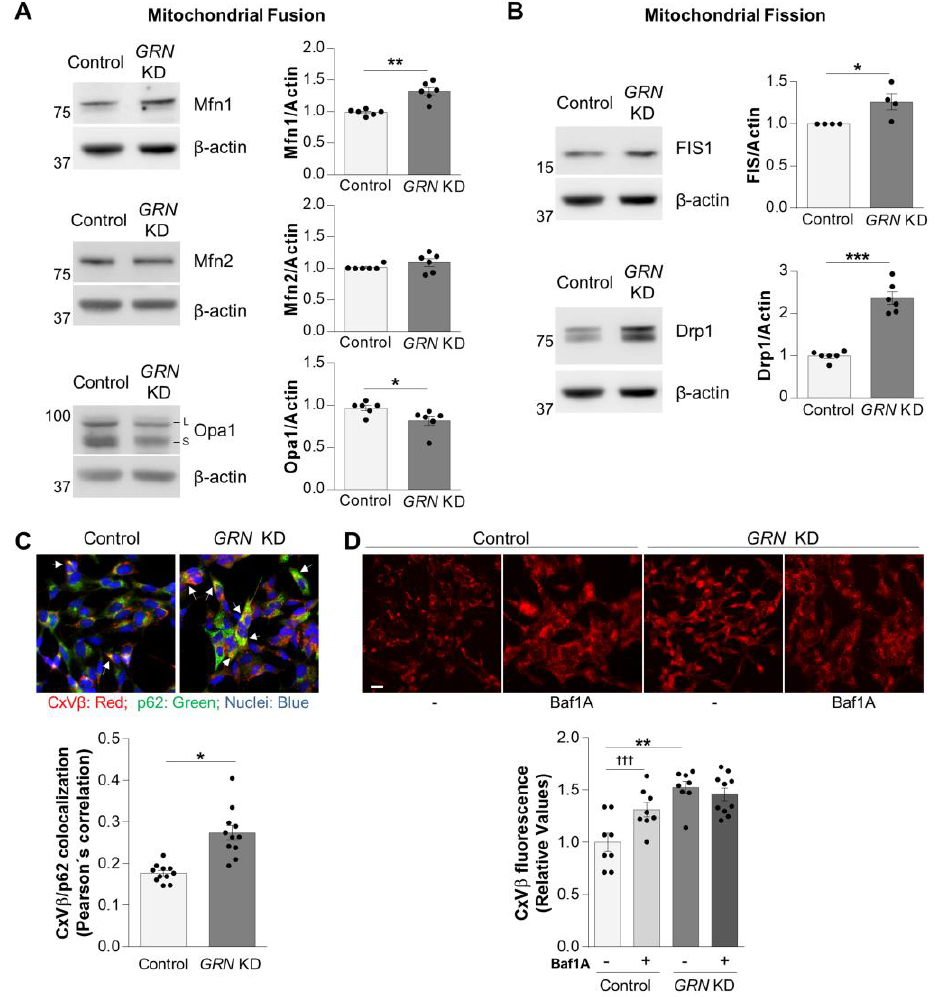
Figure 4. PGRN deficiency induces mitochondrial accumulation by blocking the lysosomal degradation of damaged mitochondria. ( A ) Representative immunoblots showing the levels of the mitochondrial fusion proteins mitofusin 1 (Mfn1), mitofusin 2 (Mfn2) and Opa1. β -actin was used as a loading control. Plots represent the average ± SEM of six independent measurements for each protein. ( B ) Representative immunoblots showing the levels of the mitochondrial fission proteins FIS1 and Drp1. β -actin was used as a loading control. Plots represent the average ± SEM of six independent measurements for each protein. The statistical analysis of protein level measure- ments was performed using Student’s t -test. * p < 0.05, ** p < 0.01; *** p < 0.001. ( C ) Microscopy images showing the colocalization of the mitochondrial marker CxV β (in red) and the autophagic cargo adapter p62 (in green) in control and GRN KD SH-SY5Y cells. The colocalization between the two fluorophores was assessed by measuring the Pearson’s correlation coefficient. Plot represents